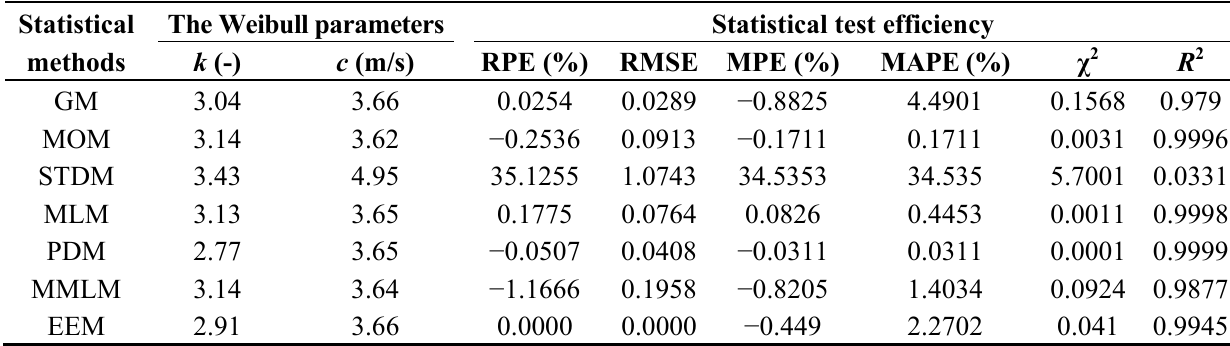
Table 8. The Weibull distribution analysis for Station-III at 20 m height.